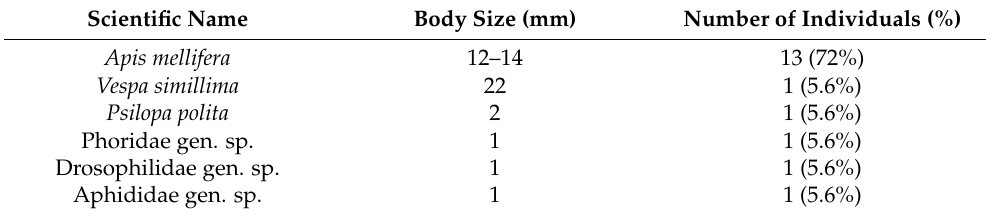
Table 2. List of insects in the capture test. Sweeping was conducted 500 times in the experimental